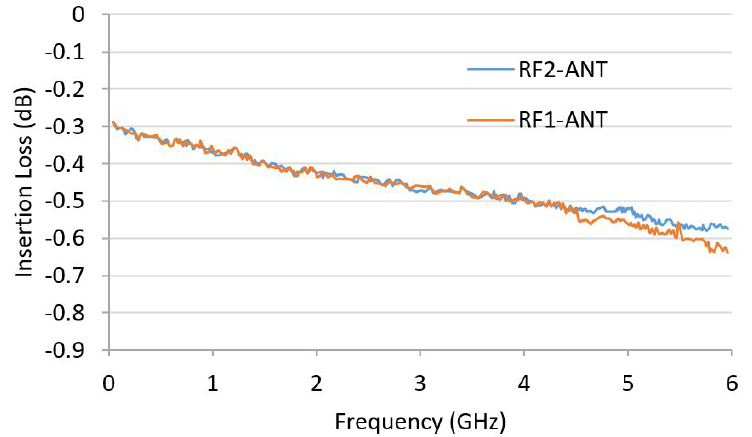
Figure 17. Measured insertion loss of the SPDT switch.